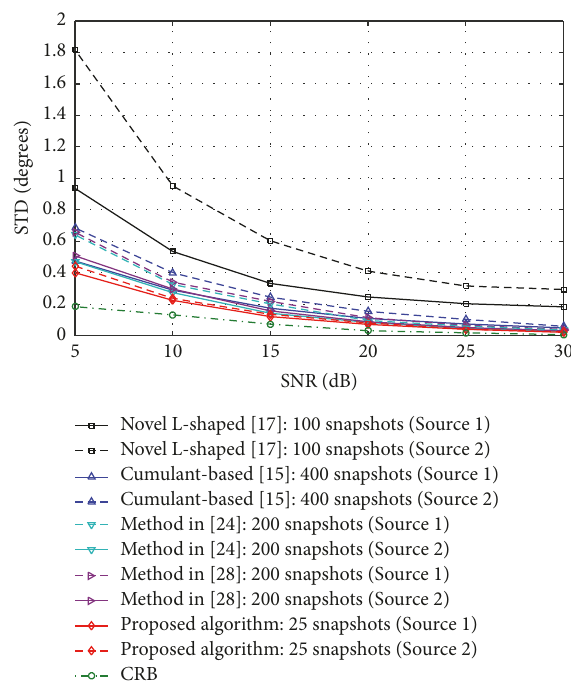
Figure2:StandarddeviationversusSNRforsource1locatedat (𝜃 1 = 70 ∘ ,𝜙 = 50 ∘ ) and source 2 at (𝜃 1